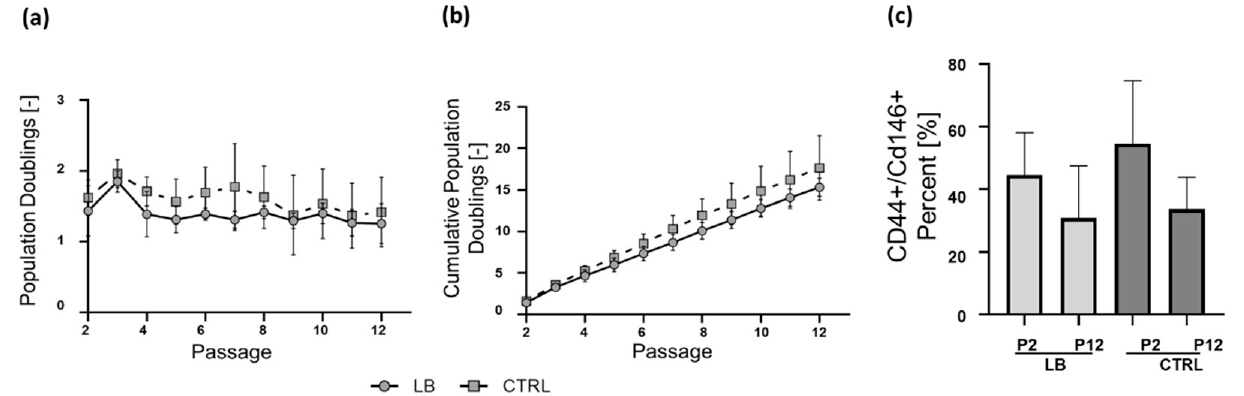
Figure 2. Long-term expansion and purity of LB cultures ( a ) Shown are the population doublings (PD) and ( b ) cumulative population doublings (CPD) for each indicated passage. Cells were sub- cultured in fixed seven-day intervals in T75 cm 2 culture flasks from P2 to P12. Cell numbers were determined using a CASY ® cell counter (LB n = 7, CTRL n = 5, repeated measures, mean ± SD results, two-way ANOVA with multiple comparisons; Sidak). ( c ) Analysis of CDPC marker expression via flow cytometry. Shown are the percentage of double positive (CD44+ and CD146+) cells in early (P2) and late passage (P12) cultures. (LB n = 7, CTRL n = 5, one-way ANOVA with multiple comparisons; Tukey).